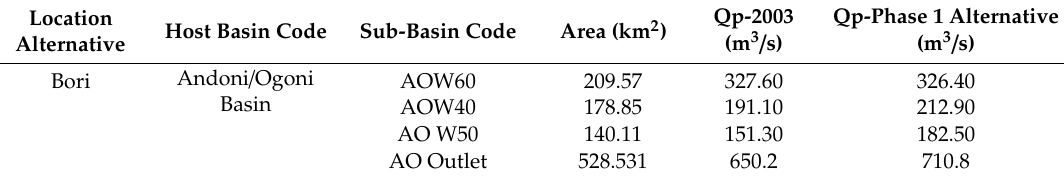
Table 5. The modelled result for peak flow responses to the Bori alternative location in the Andoni-Ogoni Basin. AO = Andoni / Ogoni; Qp = peak discharge; Qp-2003 = peak discharge based on the 2003 LULC condition; Qp-Phase 1 Alternative = peak discharge based on Phase 1 alternative LULC condition.